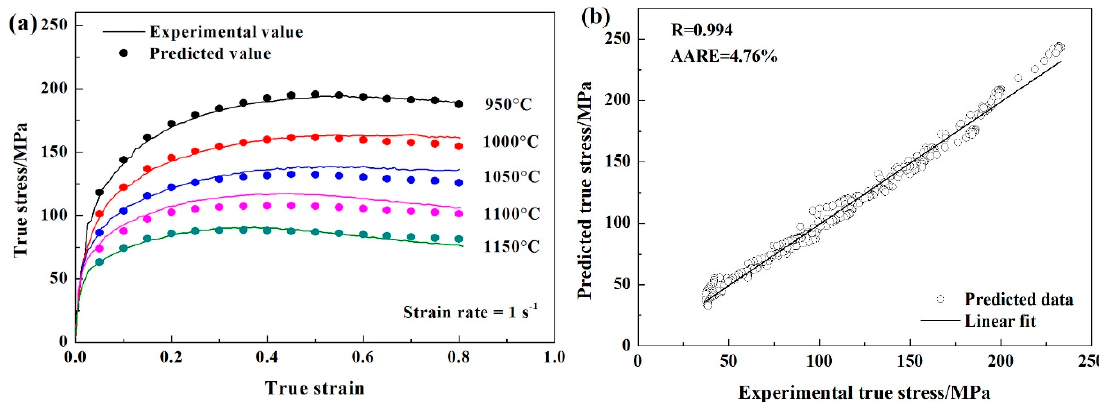
Figure 8. ( a ) Comparison between the values of the experimental and predicted true stress when strain rate is 1 s − 1 ; ( b ) Correlation between experimental and predicted true stress in this study.